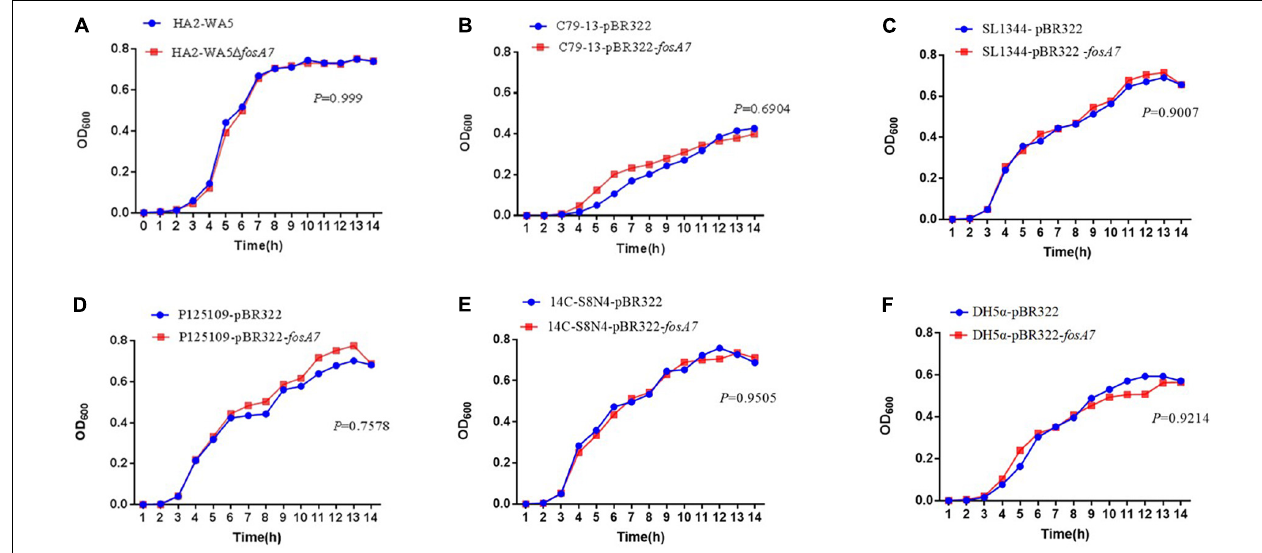
FIGURE 2 | Growth curves of (A) fosA7 -positive S . Derby HA2-WA5 and its fosA7 deletion mutant; (B) S . Typhimurium SL1344-pBR322 and SL1344-pBR322- fosA7 ; (C) S . Pullorum C79-13-pBR322 and C79-13-pBR322- fosA7 ; (D) S . Enteritidis P125109-pBR322 and P125109-pBR322- fosA7 ; (E) S . Derby 14C-S8N4-pBR322 and 14C-S8N4-pBR322- fosA7 ; (F) E. coli DH5 α -pBR322 and DH5 α -pBR322- fosA7